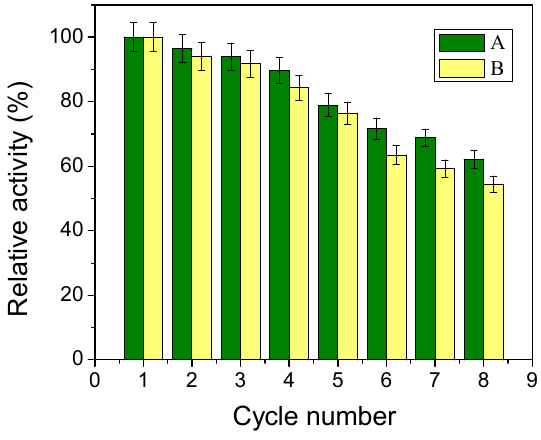
Figure 9. The reusability of ( A ) NHase@Dop-TAMS; and ( B ) NHase@TAMS.